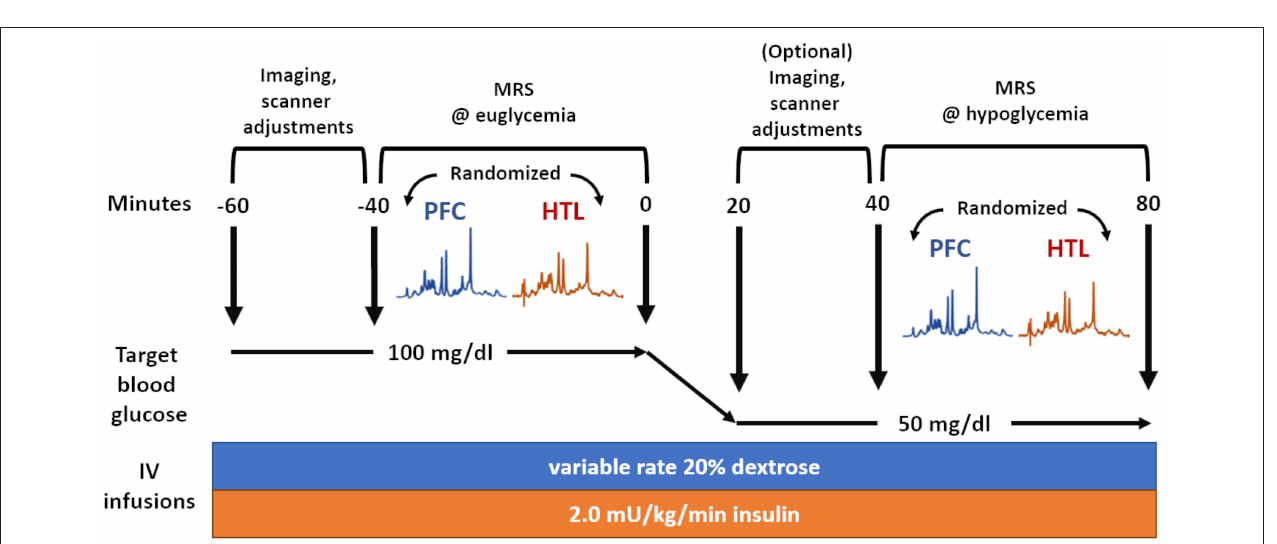
reported if two metabolites showed strong negative correlation ( r < − 0.7), or if one of the individual concentrations in Glu + Gln or Glc + Tau did not meet the mean CRLB ≤ 20%